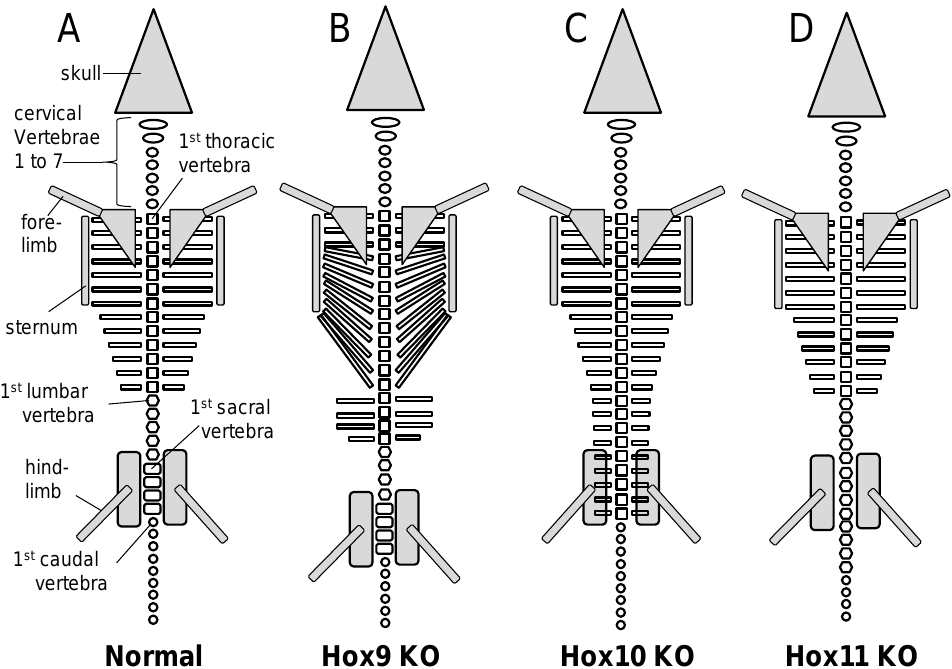
Figure 10. Mouse knockout (KO) skeletal phenotypes for Hox9, Hox10 and Hox11 genes. ( A ) Normal newborn mouse. ( B ) Mouse knocked out for all eight Hox9 genes (a9, b9, c9, d9, maternal and paternal). ( C ) Mouse knocked out for all six Hox10 genes (a10, c10, d10, maternal and paternal). ( D ) Mouse knocked out for all six Hox11 genes (a11, c11, d11, maternal and paternal). Figure